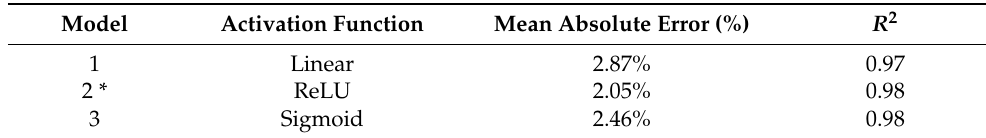
Table 5. Hyperparameter tuning for the activation function.